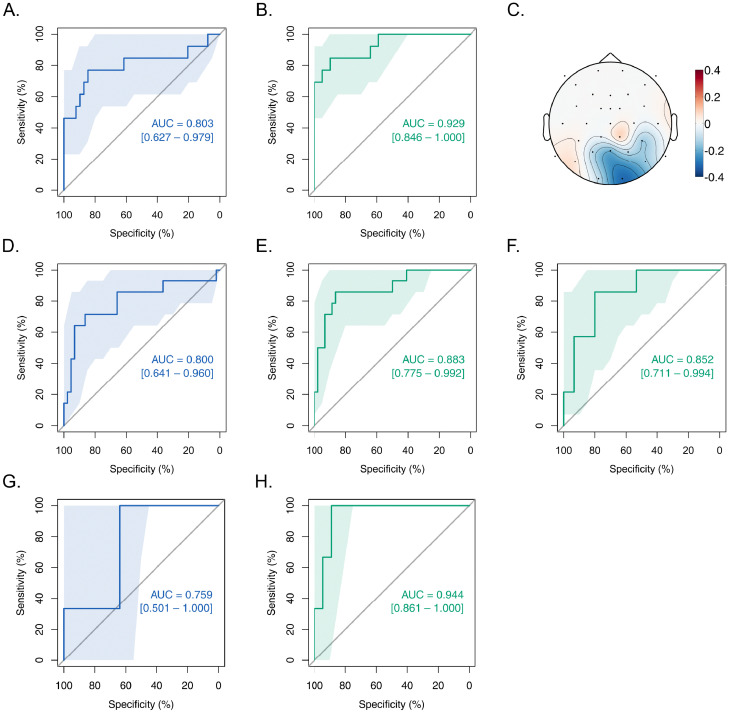
Development and validation of the P1-based biomarkers for classifying congenital cataract individuals. A. Receiver operating characteristic (ROC) curve from the first experiment involving all three groups classifying CC individuals using the MPP1 marker. B. ROC curve from experiment 1 for the SVMP1 marker. C. Optimal linear weights for the posterior electrodes for SVM-based classification, plotted as a topography (unitless). D. and E. ROC curves for MPP1 and SVMP1 based classification for experiment 2. F. ROC curve for the SVMP1 validation performance in experiment 2 with weights developed from a group of only CC and DC individuals in experiment 1, applied for the combined group of only CC and DC individuals in experiment 2. G. and H. ROC curves for experiment 2 as in panels D. and E., but with only the new CC and DC participants (NCC = 3, NDC = 10, NControl = 29). Each panel displays the areas under the ROC curves (AUCs) and their 95% confidence intervals (CIs). CI bands for sensitivities are depicted as shaded areas (all sensitivity CIs obtained with stratified bootstraps, n = 2000). All ps < .05 for the ROCs. For statistical details see Table 1.